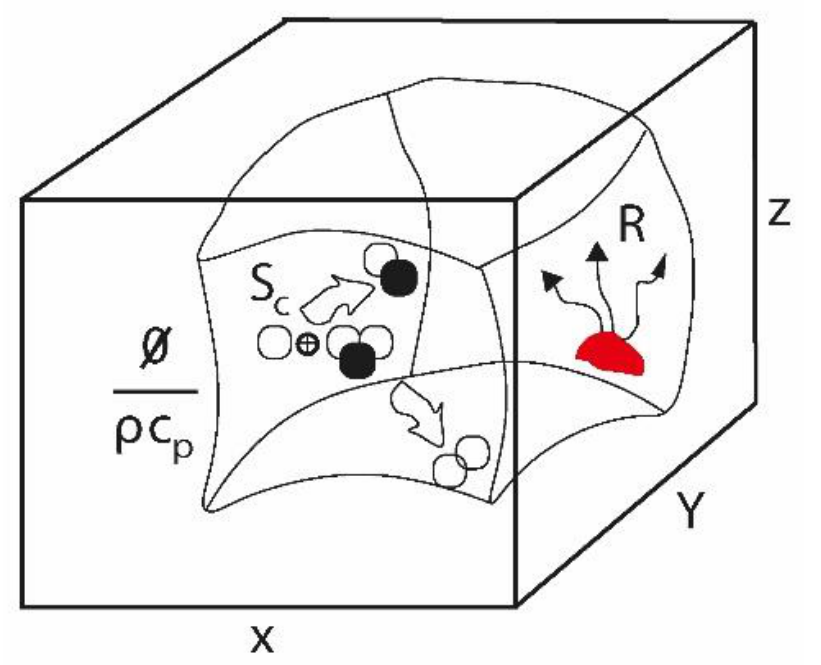
Figure 3. Three-dimensional representation in a volume element of heat dissipation through shear ∅ stress ( ρ c p ), energy variation in chemical reactions (S c ) and thermal radiation